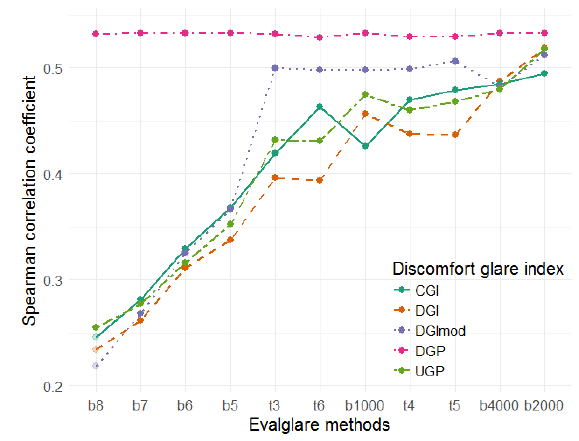
Figure 5. Comparison of Spearman rho for each discomfort glare index between the studied evalglare methods (laboratory study).